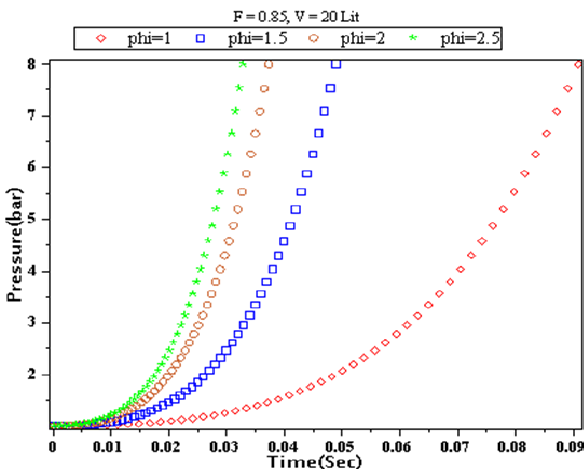
Fig. 2 .effect of solid fuel concentration on pressure.